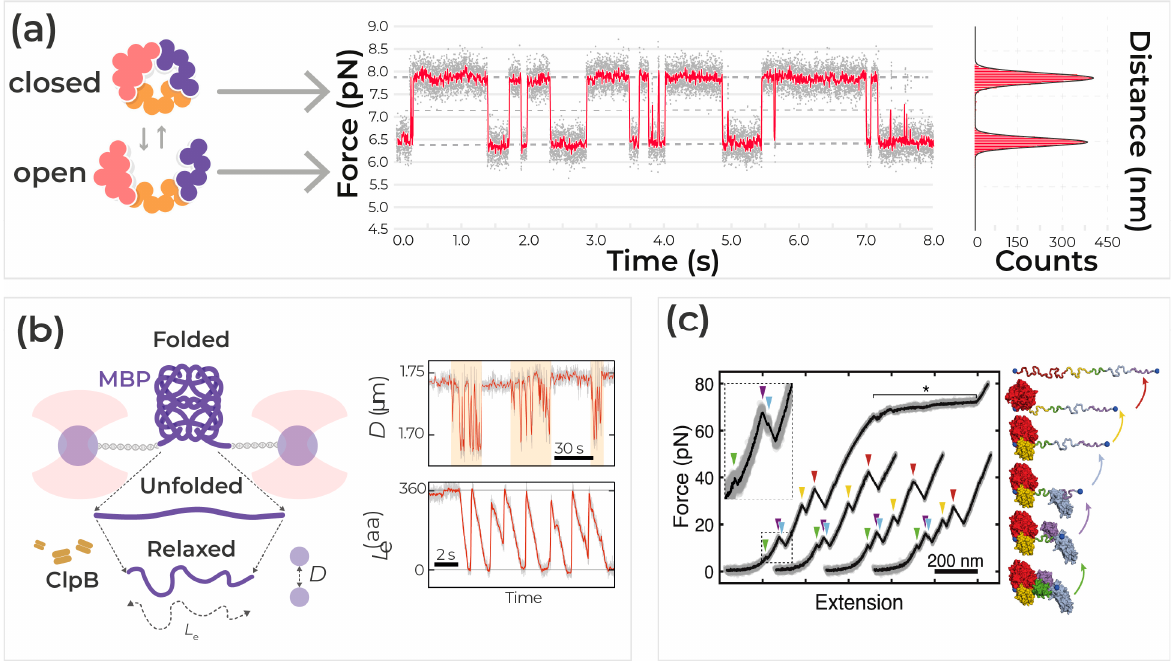
Figure 5. Protein Dynamics ( a ) Conformational states of example proteins moving from a closed to an open state correlated with fluctuations in force (pN range) over time (s). Each conformational state corresponds to a force level. Further on the right is a histogram denoting the events, or counts, of the protein in the closed state versus the open state. ( b ) ClpB is a processive translocase. This introduces the work of Sander Tans on the extrusion activity of a disaggregase. Hsp100 disaggregases such as ClpB and Hsp104 are proposed to catalyze this reaction by translocating polypeptide loops through their central pore. This model of disaggregation is appealing, as it could explain how polypeptides entangled within aggregates can be extracted and subsequently refolded with the assistance of Hsp70. However, the model is also controversial, as the necessary motor activity has not been identified. ( c ) Maciuba et al. illustrate representative force extension curves (FECs) from the first pulls of elongation factor-G (EF-G). Overstretching of the DNA handles (asterisk) is shown only for the first trace. All traces display the characteristic unfolding pattern of the five-domain protein (arrowheads, color-coded by domain). The inset shows a magnification of the low-force region from the first FEC. Figures are adapted with permission from reference [141] Copyright (2020) Springer Nature, and reference [72] Copyright (2021), Springer Nature.